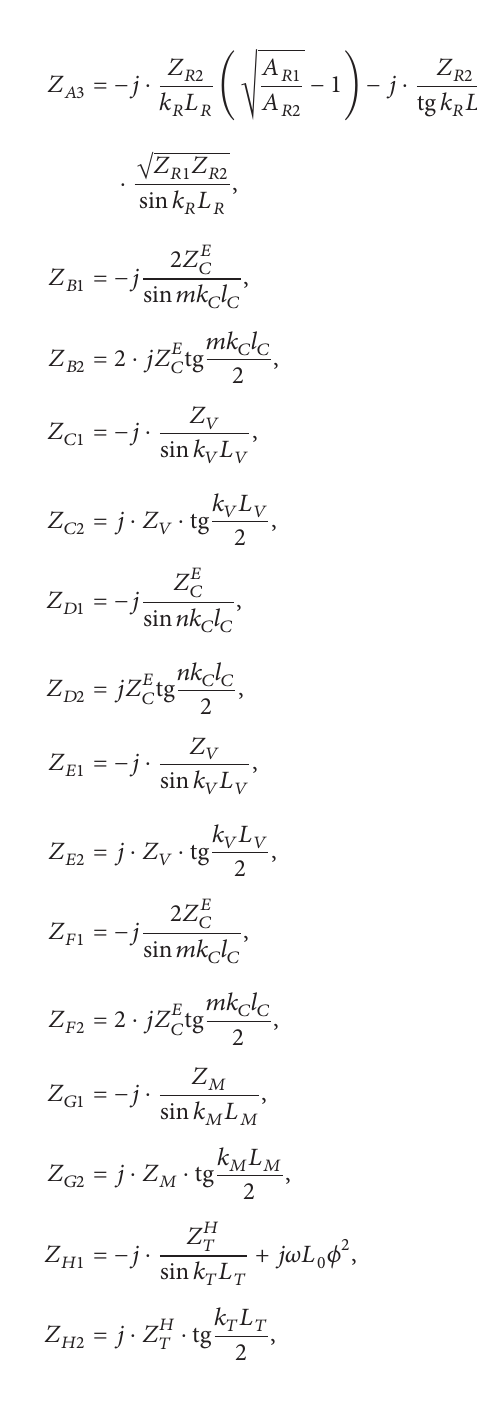
Figure 2: Equivalent circuit of the Hybrid transducer in